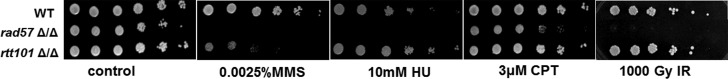
Sensitivity of the mutant strains to DNA-damaging agents. Spot assays comparing the sensitivity of the wild-type SN152 (WT) and the mutant strains. Cells were grown as described in the section Materials and Methods, diluted, and spotted onto plates with the indicated concentrations of MMS, HU, CPT, and indicated dose of IR. The strains were cultured on solid SC-Met−/Cys− medium and photographed after 2 d growth at 30°.